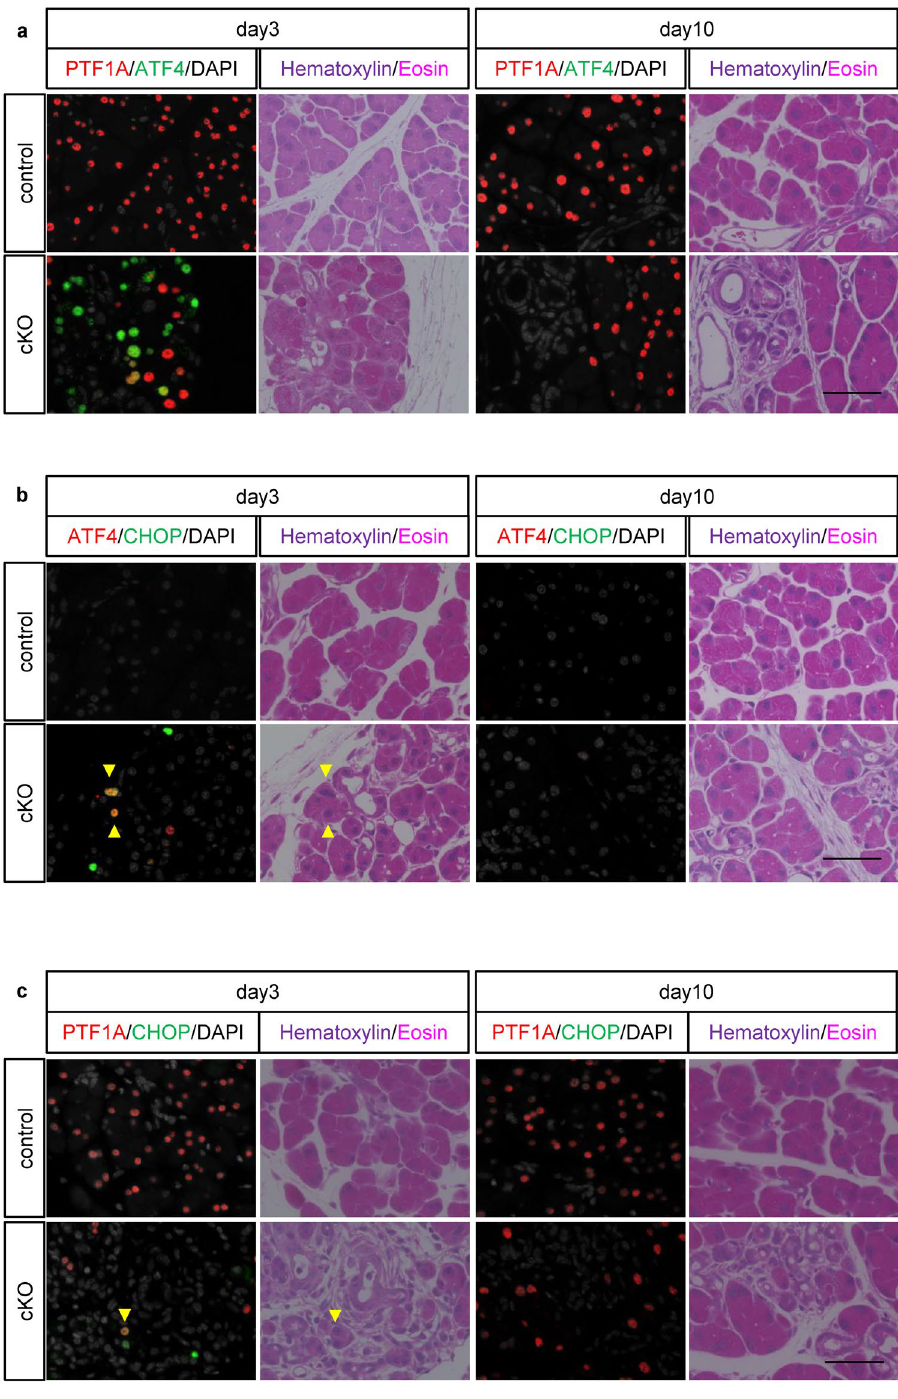
Figure 6. ATF4 and CHOP were upregulated in Ptf1a cKO mice on day 3 but recovered by day 10. Immunofluorescence of ( a ) PTF1A and ATF4 ( b ) ATF4 and CHOP, and ( c ) PTF1A and CHOP with hematoxylin-eosin staining on days 3 and 10. Arrowheads indicate CHOP and ATF4 double positive nuclei in ( b ) or a PTF1A and CHOP double positive nucleus in ( c ). Hematoxylin-eosin was stained on the same sections after immunofluorescence. Scale bars = 50 μ